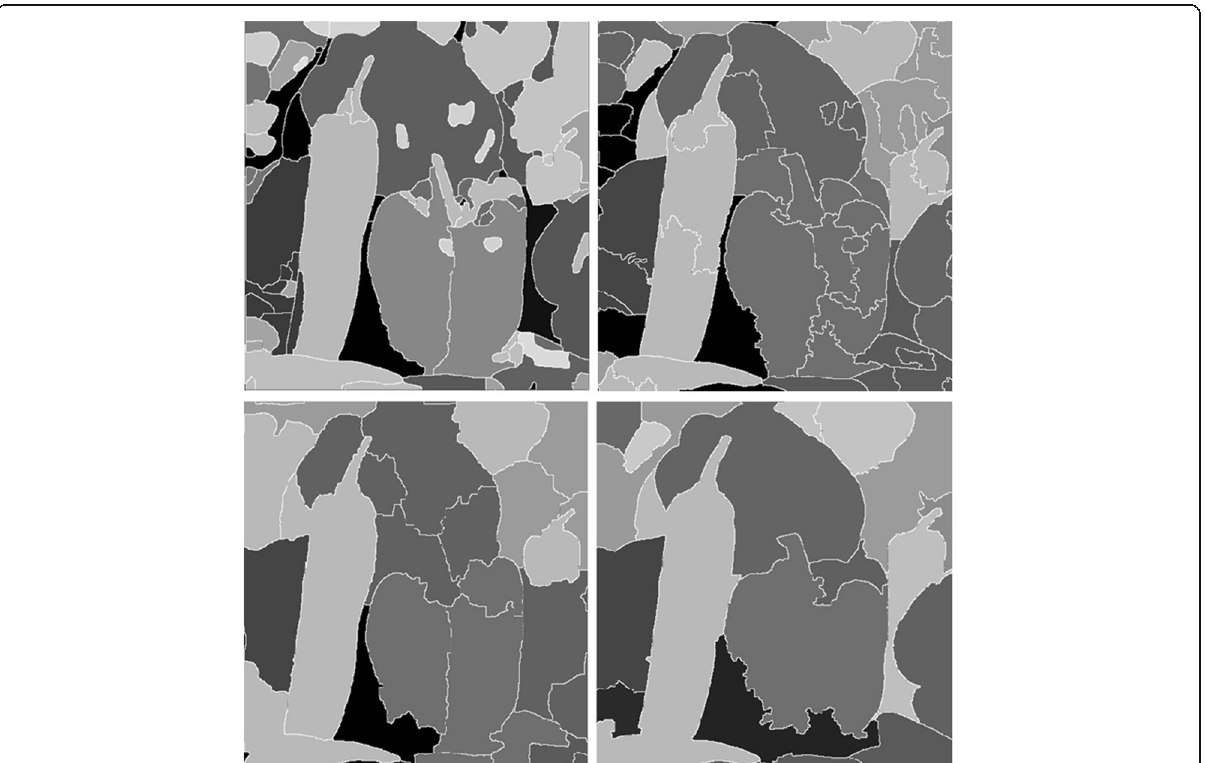
Fig. 7 Peppers image segmentation results (the upper left is the propose method, the upper right is the FCM method, the lower left is K-means method, and the lower right is the KFCM method)